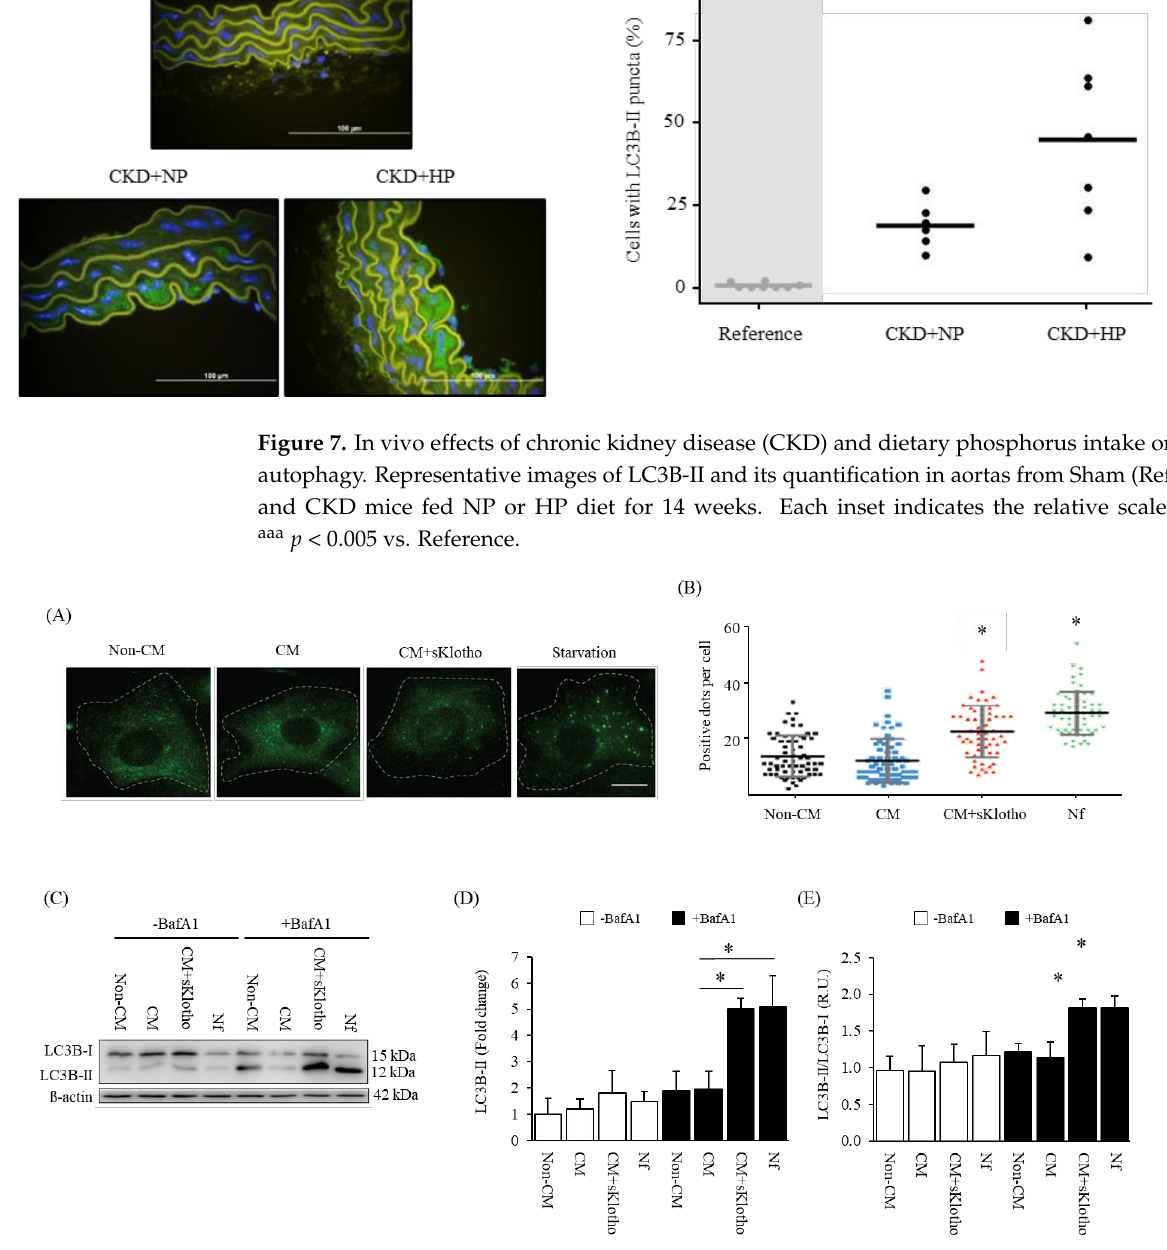
Figure 7. In vivo effects of chronic kidney disease (CKD) and dietary phosphorus intake on aortic autophagy. Representative images of LC3B-II and its quantification in aortas from Sham (Reference) and CKD mice fed NP or HP diet for 14 weeks. Each inset indicates the relative scale in µm. aaa p < 0.005 vs. Reference..